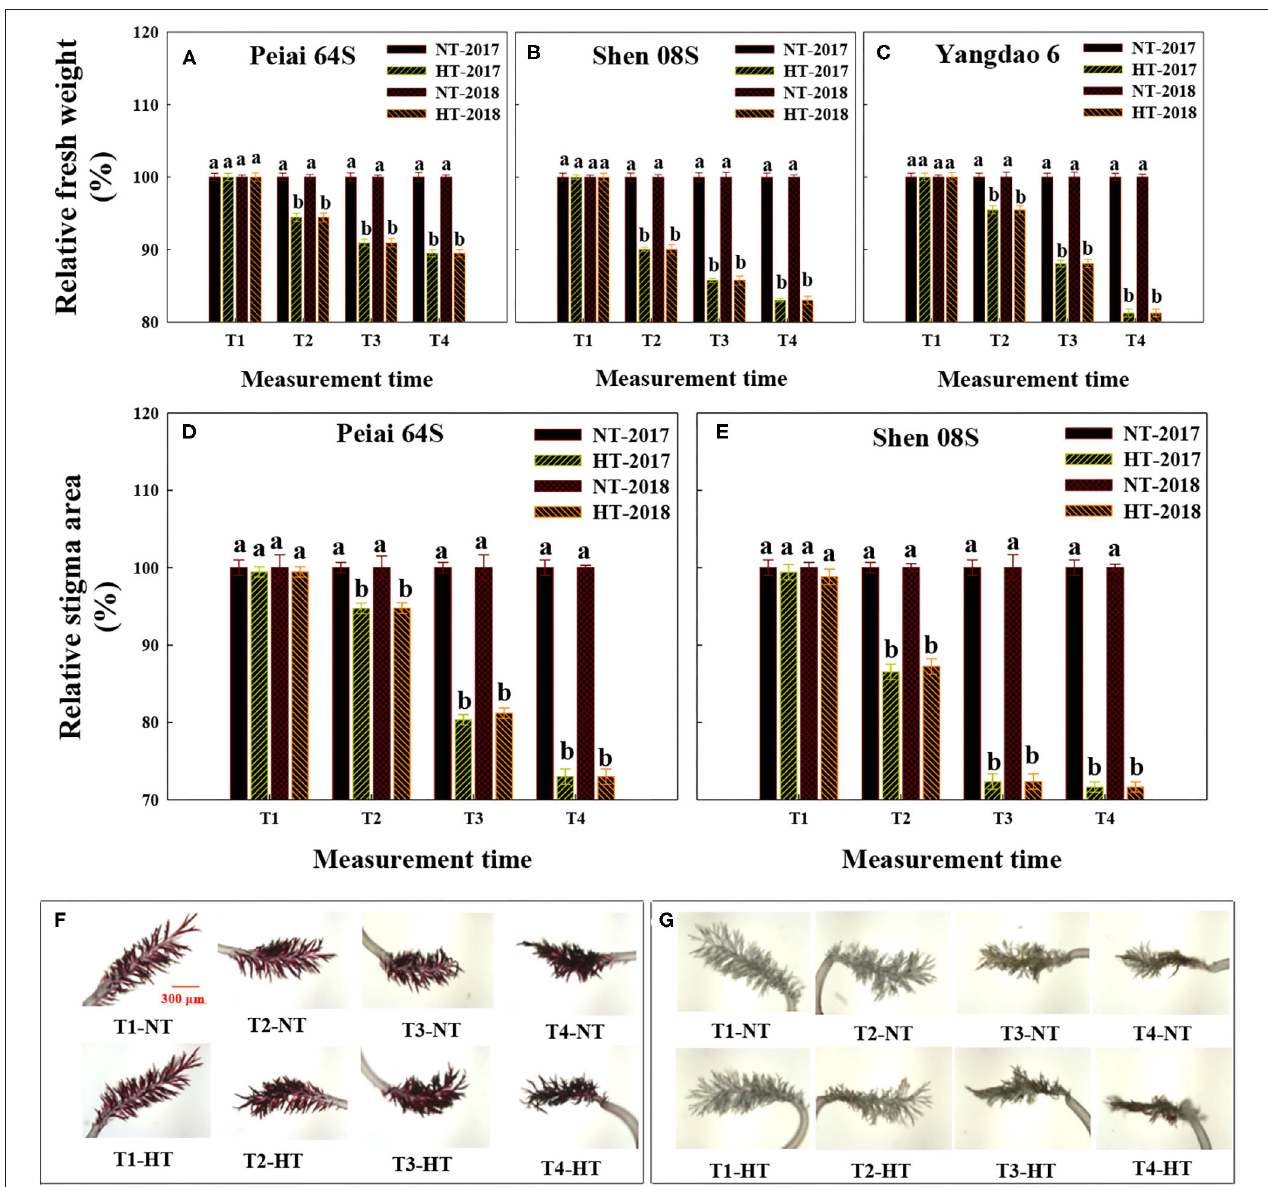
FIGURE 2 | Effect of high-temperature stress during anthesis on the stigma fresh weight (A–C) and stigma area (D–G) of rice. NT and HT represent normal temperature and high temperature, respectively, and the NT is taken as control. Data are expressed as relative values, and those of controls are taken as 100%. Pictures in (F,G) are Peiai 64S and Shen 08S, respectively. T1: 12:00h on the first day during the temperature treatment; T2: 14:00 h on the first day during the temperature treatment; T3: 14:00h on the second day during the temperature treatment; T4: 14:00h on the first day after the temperature treatment. The bars in (A–E) are SD of three biological replications. Different letters above the bars represent significant differences at the P ≤ 0.05 level within the same line and the same measurement time. The images of stigma area in (F,G) were taken at 50 ×